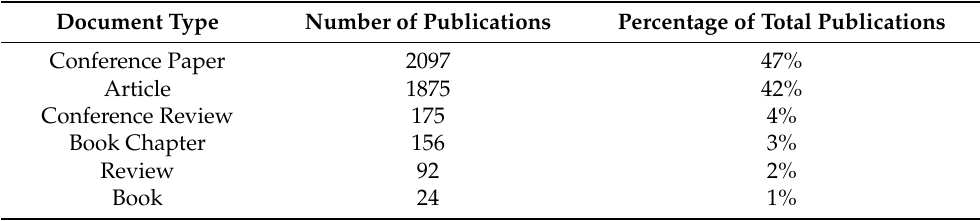
Table 4. Bitcoin publications by document